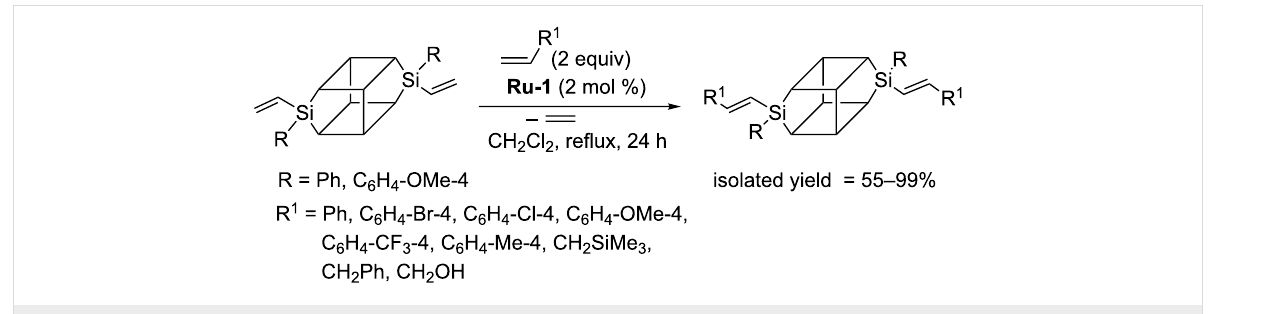
Scheme 11: Cross metathesis of DDSQ-2SiVi with